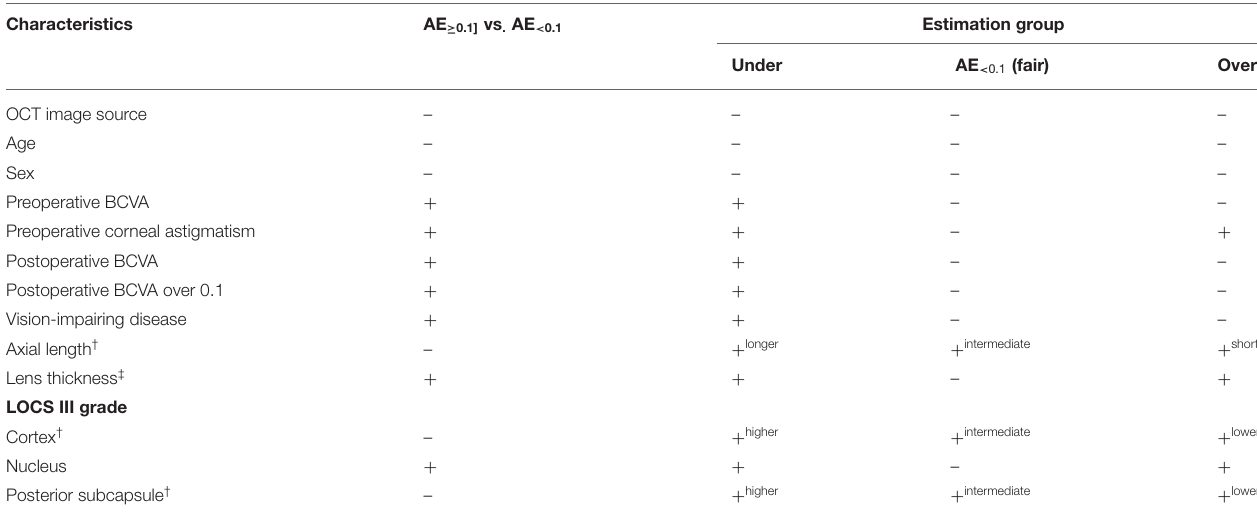
TABLE 5 | Error analysis of model performance in clinical